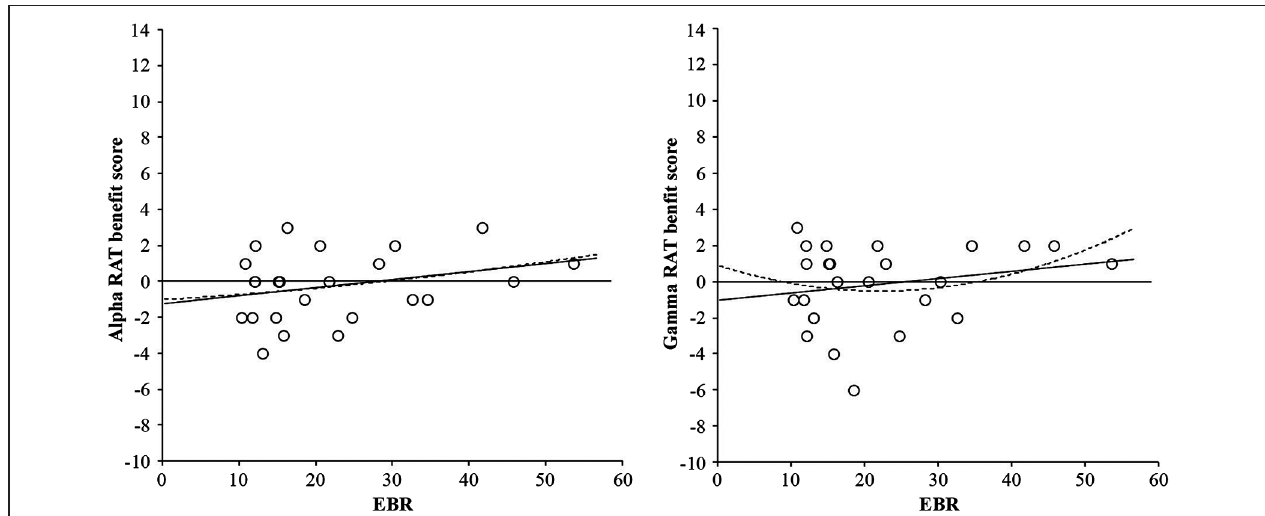
beats and EBR (right-hand graph) . Benefit scores were calculated by subtracting performance in the control condition from performance in the binaural beat condition (either alpha or